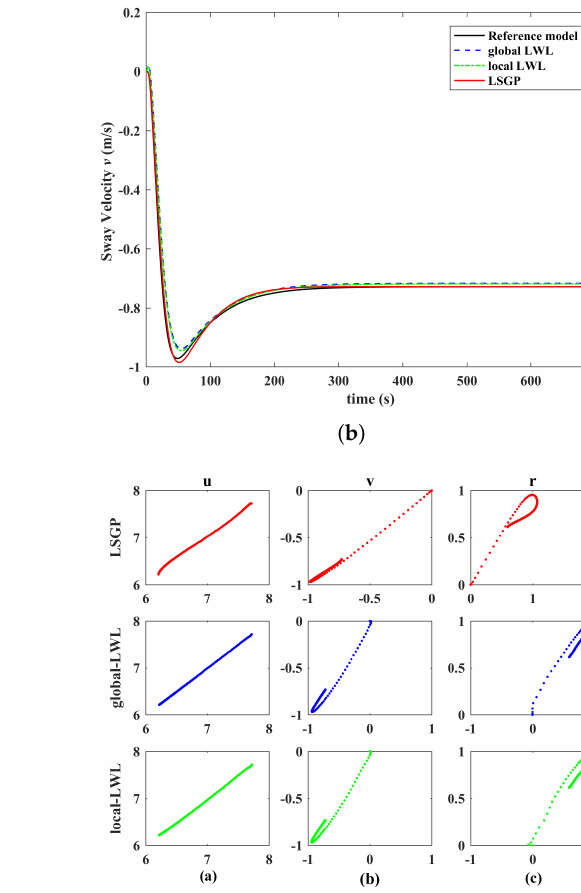
Figure 8. Comparison results of ship motion states for the simulated ZZ-30 ◦ -5 ◦ test. It shows the changes of the ship’s motion state on the three degrees of freedom, ( a ) is the Surge Velocity, ( b ) is the Sway Velocity, and ( c ) is the Yaw rate. ( d ) Scatter plot of simulation prediction and reference model, the abscissa is simulation prediction, and the ordinate is reference model in each sub-figure.